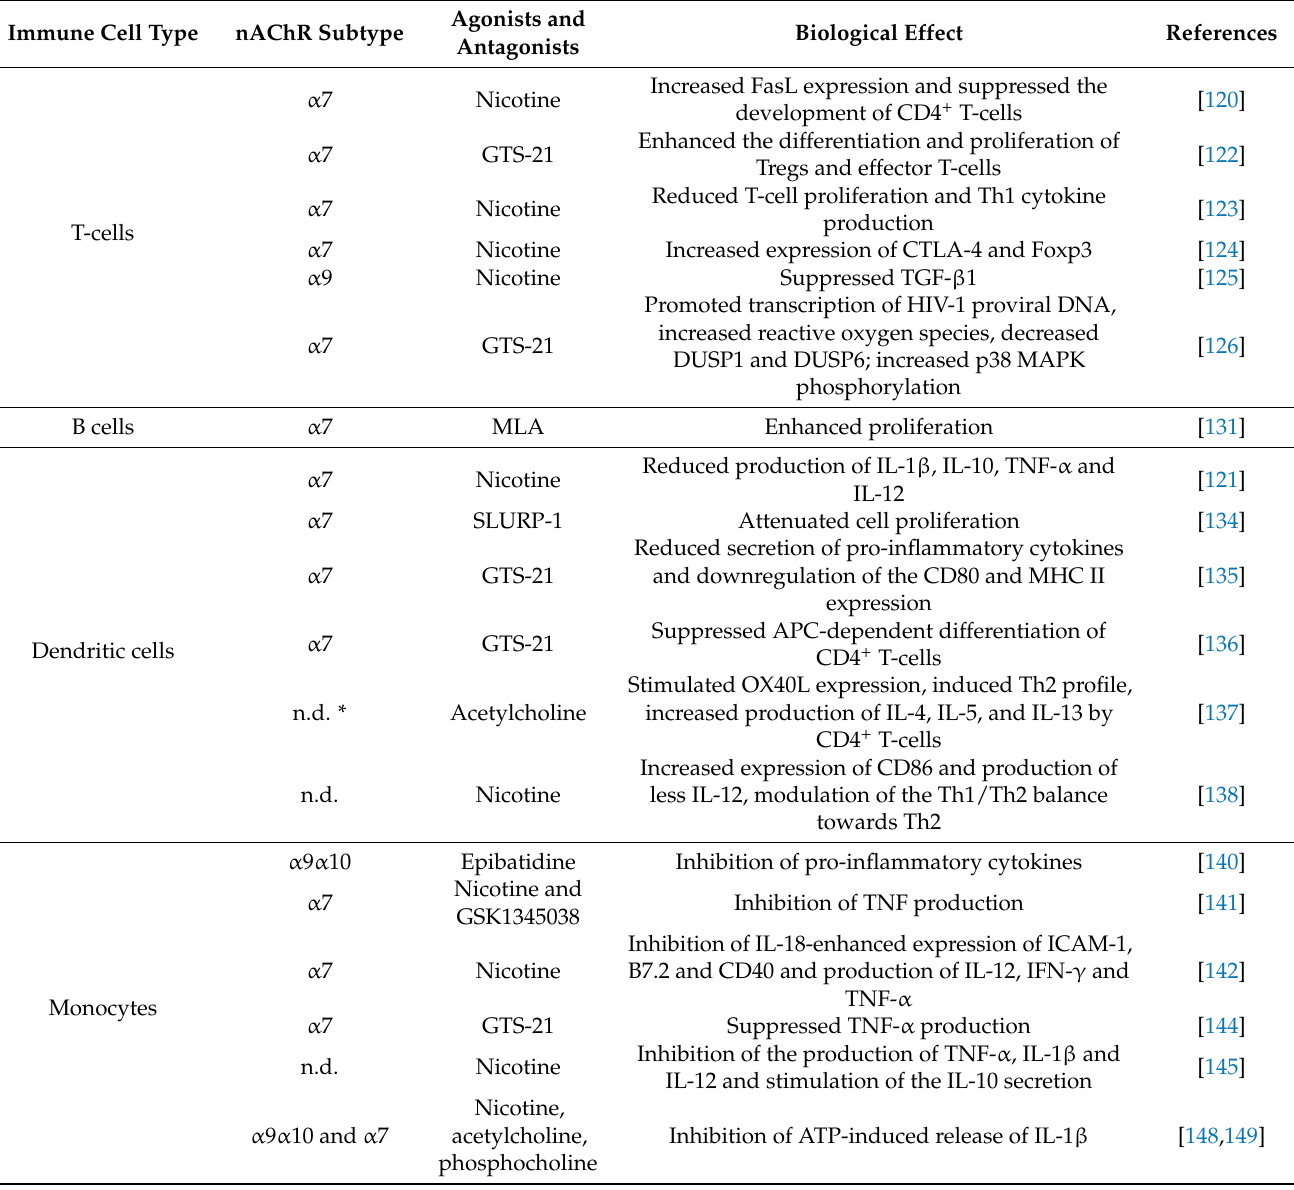
Table 1. The biological effects of the actions on the α 7, α 9 and α 9 α 10 nAChRs in different immune